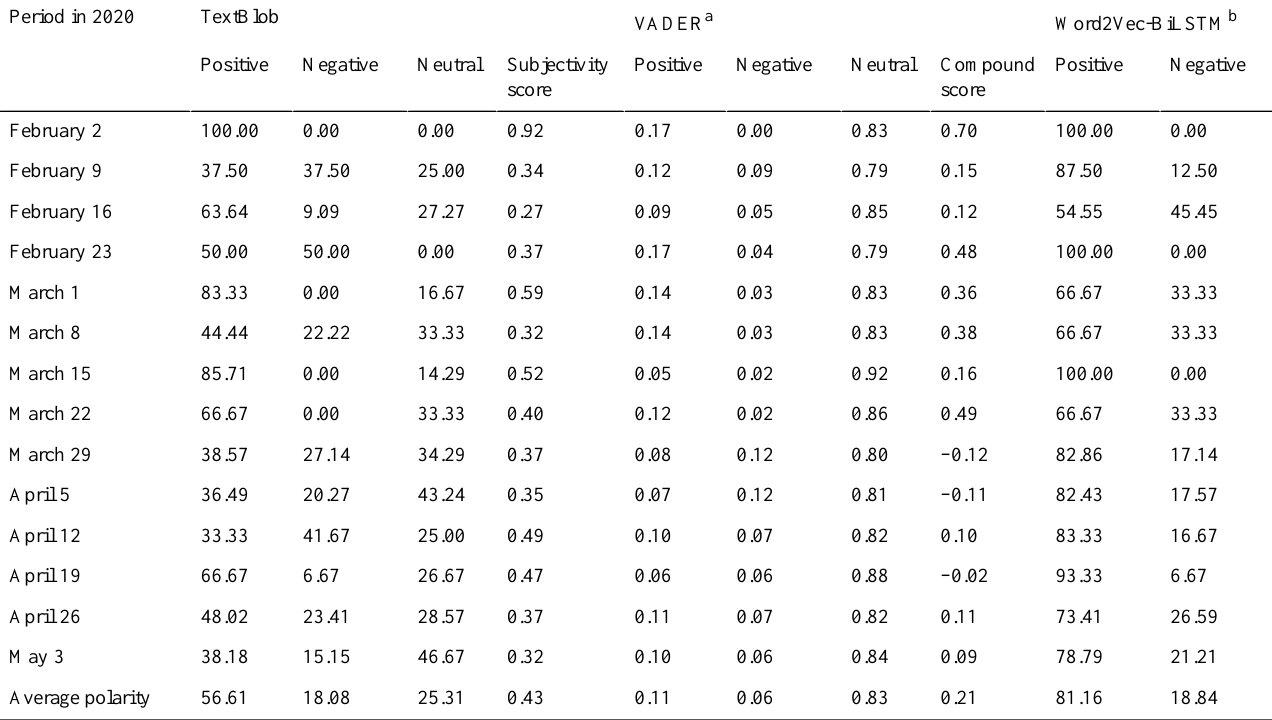
Table 2. Sentiment polarities in media communications (Twitter posts) analyzed using the TextBlob, VADER, and Word2Vec-BiLSTM